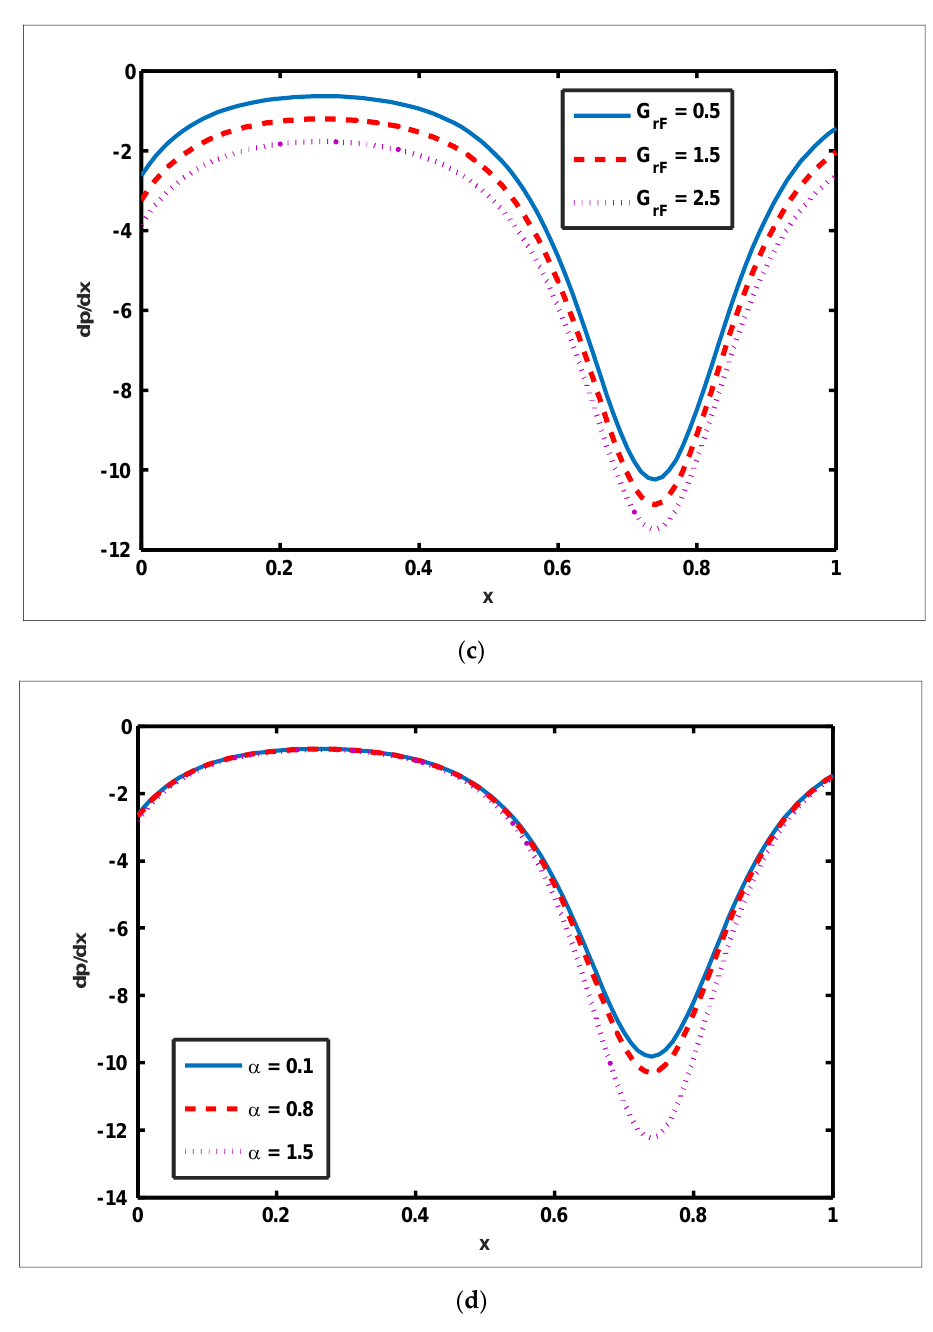
Figure 5. Effect of Weissenberg number, thermophoresis, Grashof number of nanoparticles, and slip parameter on pressure gradient. Values of other physical parameters are ( a ) 𝑁 𝑡 = 0.3, 𝑁 𝑇𝐶 =